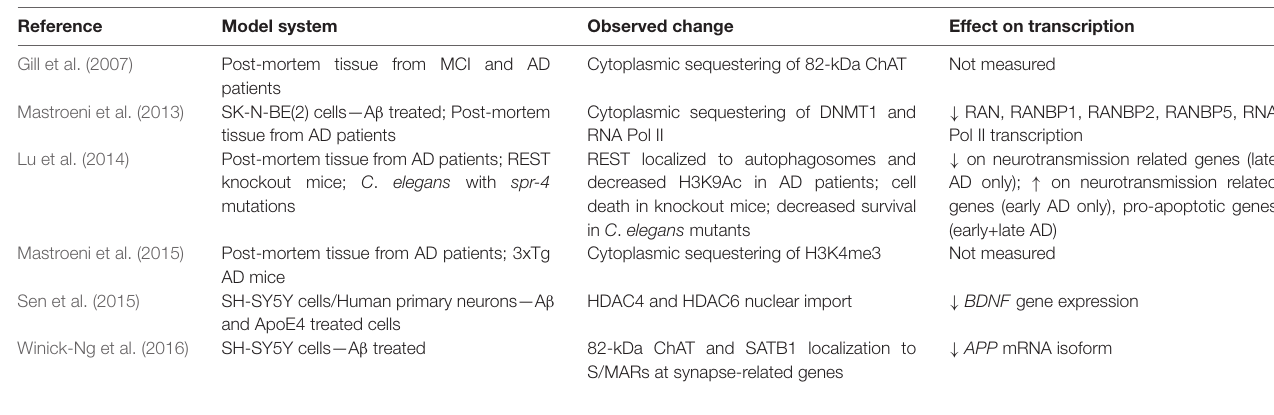
TABLE 2 | Mislocalized proteins in AD and effects on